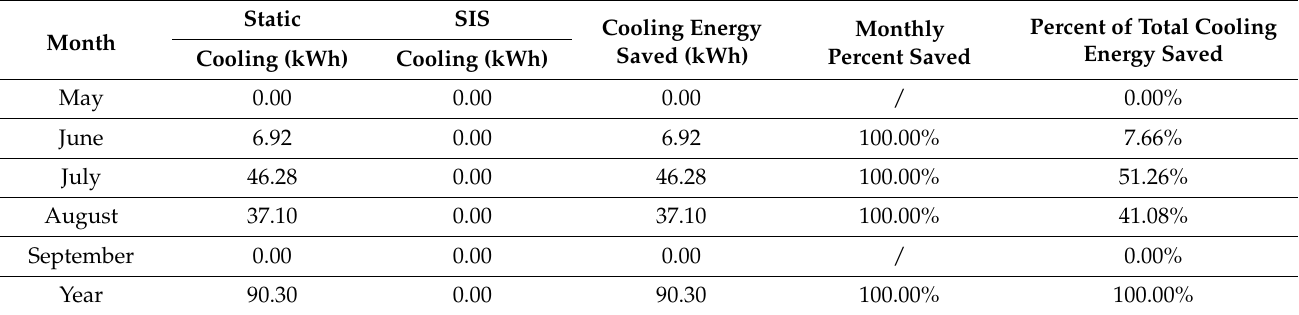
Table 7. Comparison of cooling energy consumption for static and SIS-integrated windows for the prototypical detached house.